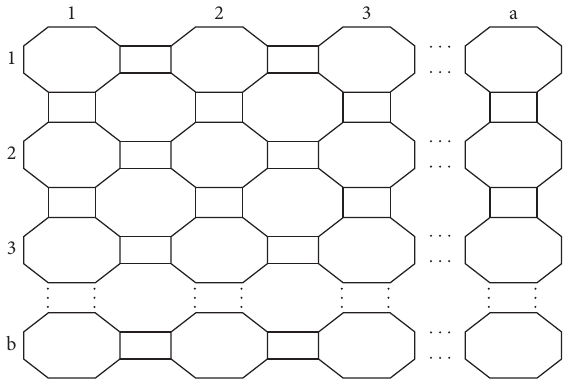
Figure 7: Type I-C